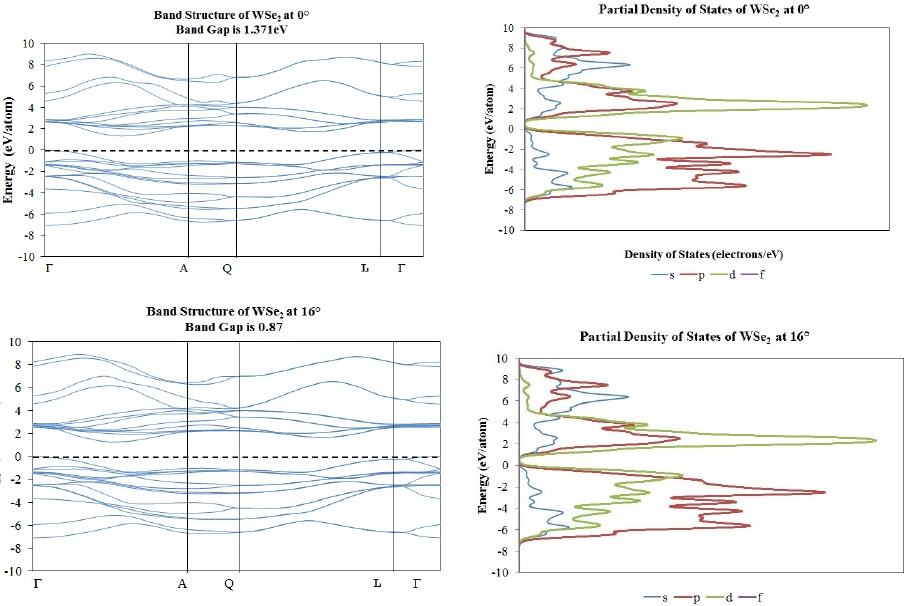
Figure 8. Band structure and partial density of states plots corresponding to 0° ( top ) and 16° ( bottom ) of rotation in WSe 2 molecular structure.